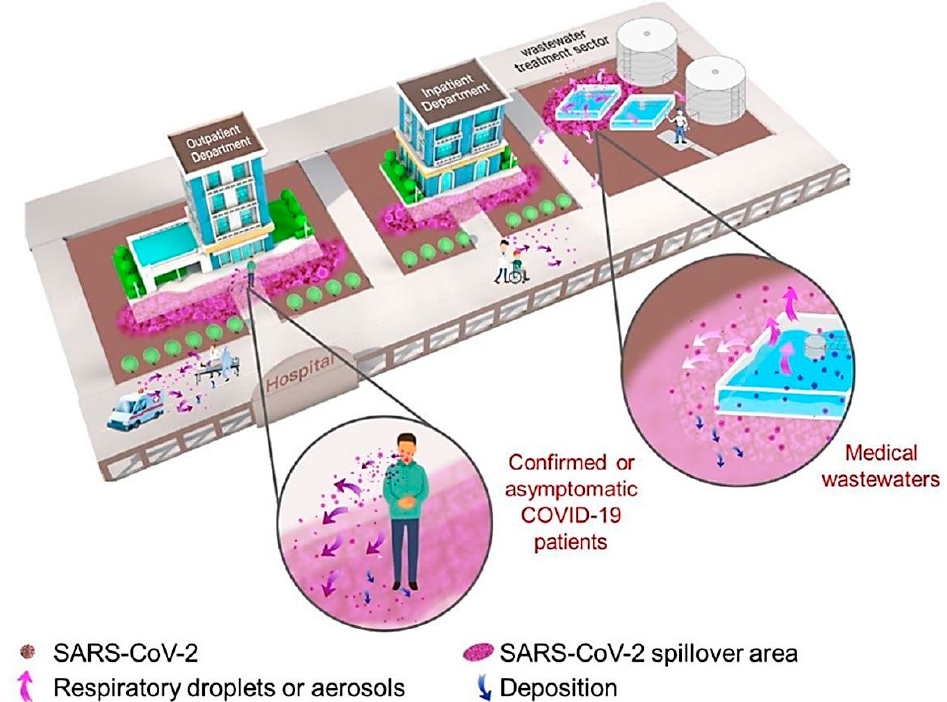
Figure 6. SARS-CoV-2 spillover and possible transmission in high-risk zones of hospital exterior environs (Adapted from [61]).